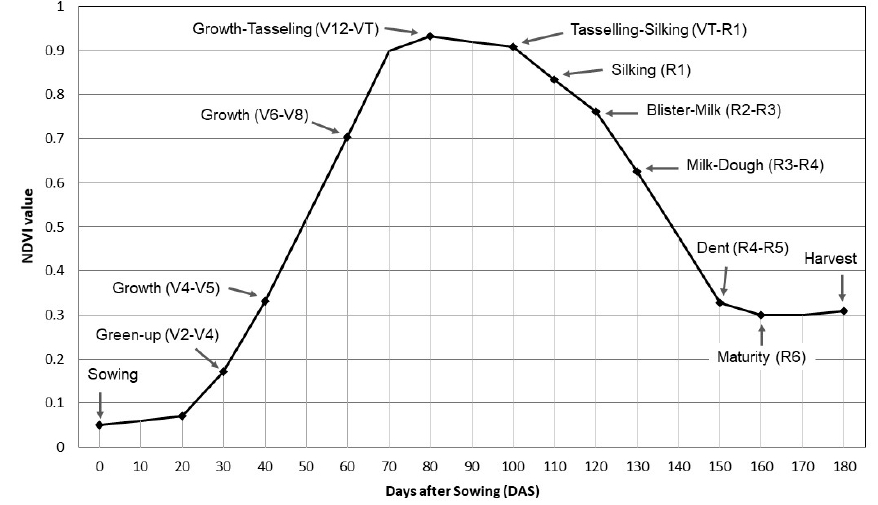
Figure 3. Evolution of NDVI according to the number of days after sowing (DAS) for the different valid images that cover the maize cycle during 2017. The main development stages are indicated according to Ritchie et al. [31].